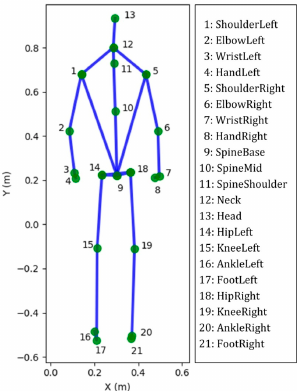
Figure 1. The 25 joints skeleton computed by Microsoft Kinect software. Twenty-one out of 25 joint labels, shown in standing position. Four very close joints are not illustrated, namely HandTipLeft, HandTipRight, ThumbLeft and ThumbRight.